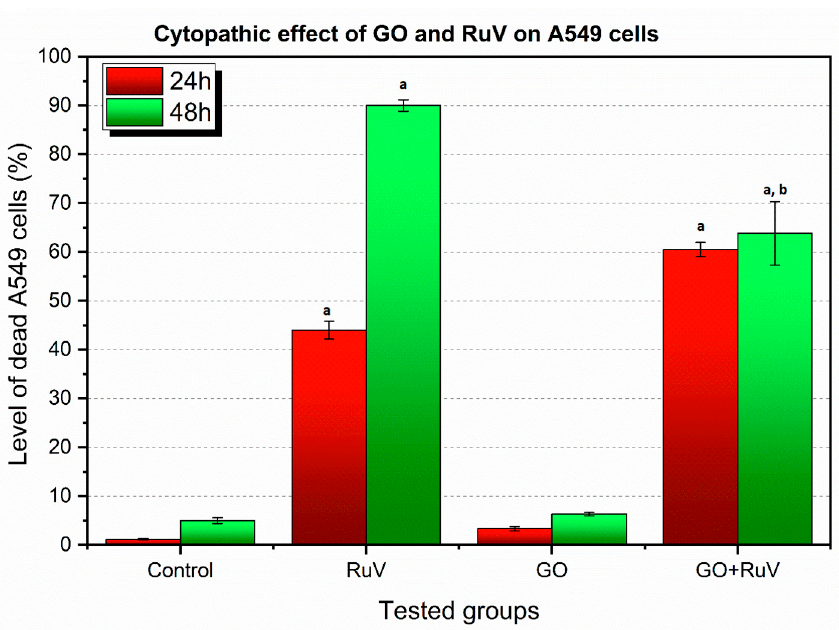
Figure 5. Percentage of cytopathic effect in A549 cell line. RuV—cells infected with RuV, GO—cells with graphene added, GO + RuV—cells infected with RuV and with graphene added. Statistical significance at p < 0.05, a: when compared to control group; b: when compared to RuV group.